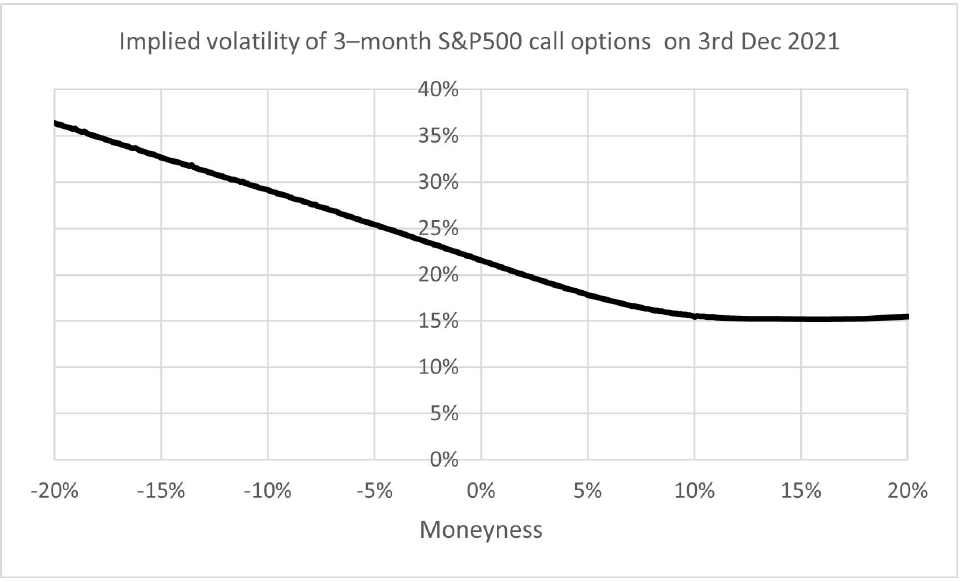
Figure 3. The implied volatilities on options on the S&P 500 expiring on 31 March 2022, using closing prices of 3 December 2021, quoted by CBOE. The typical volatility skew is clearly present where implied volatility increases as the strike price